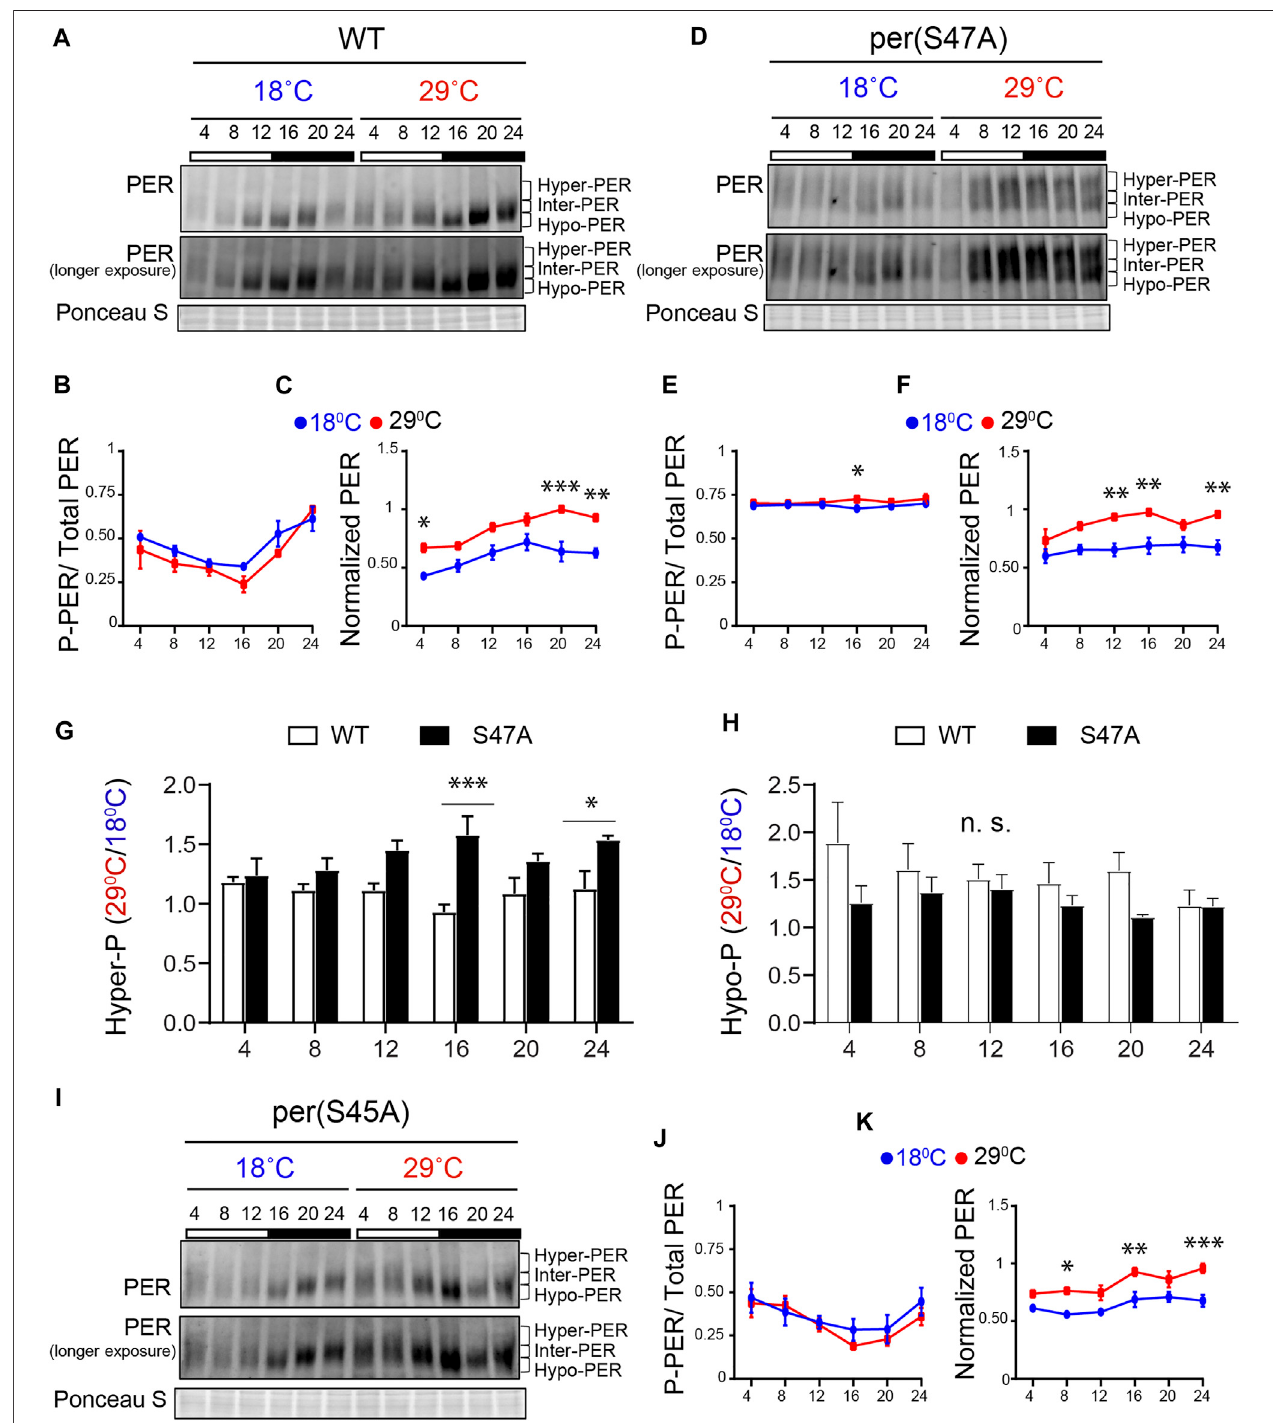
FIGURE 3 | S47A mutation causes hyper-phosphorylated PER to accumulate preferentially at high temperature. (A,D,I) Representative western blots probing head extracts from fl ies entrained to LD at 18 and 29 ° C. PER abundance was monitored throughout the day at the indicated time points. Respective genotypes are representedatthetopofeach gel.Bracketsindicatehyper-, intermediate-(inter-)andhypo-phosphorylated PER isoforms.Twodifferentexposures ofthesameblotare shown. Ponceau S was used as a loading control and for normalization. (B,F) and (J,K) Graphs show PER abundance and phosphorylation (inter + hyper) quanti fi cations. In control fl ies, both PER phosphorylation (B) and abundance (C) were scored as statistically rhythmic at 29 and 18 ° C, using the JTK_CYCLE. For phosphorylation: p < 0.05, phase = 2 at 18 ° C and p < 0.001, phase = 2 at 29 ° C. For abundance: p < 0.05, phase = 18 at 18 ° C and p < 0.001, phase = 20 at 29 ° C. For